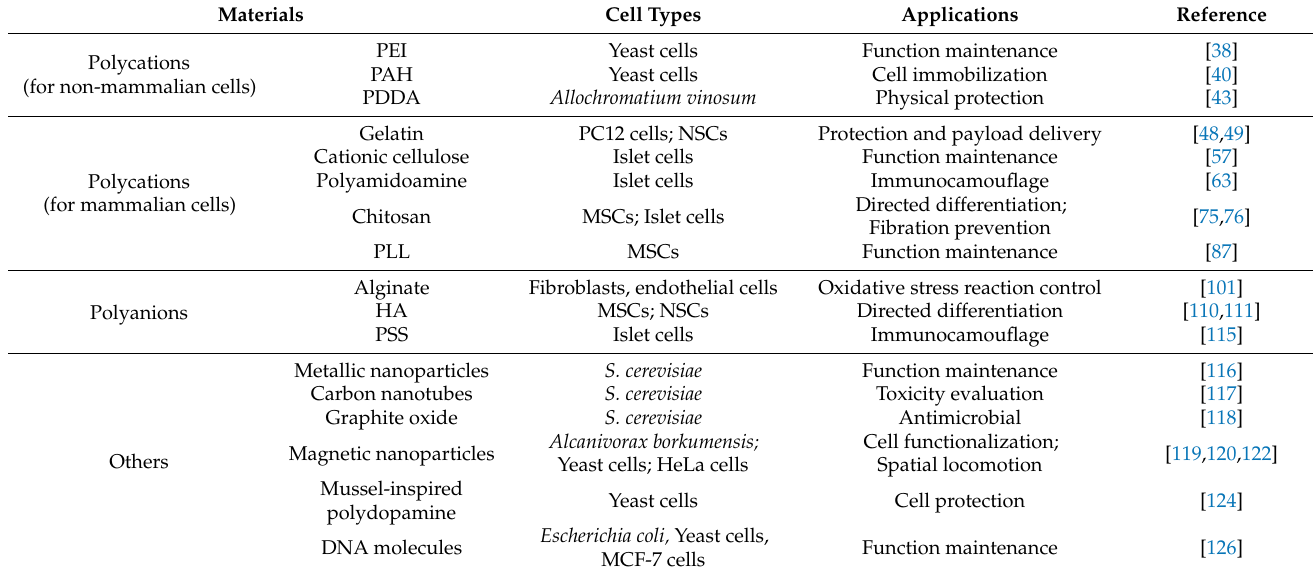
Table 1. Representative examples of materials applied in LbL cell encapsulation.